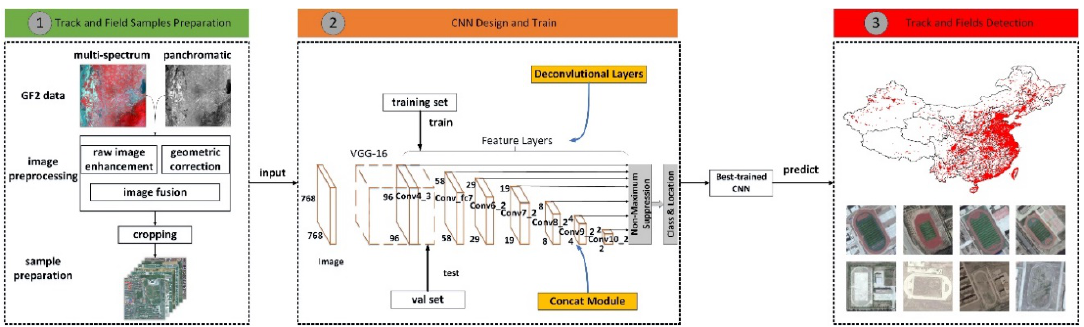
Figure 1. The workflow of the proposed approach. The methodology is composed of three steps: track and field samples preparation, CNN design and train, track and field detection.